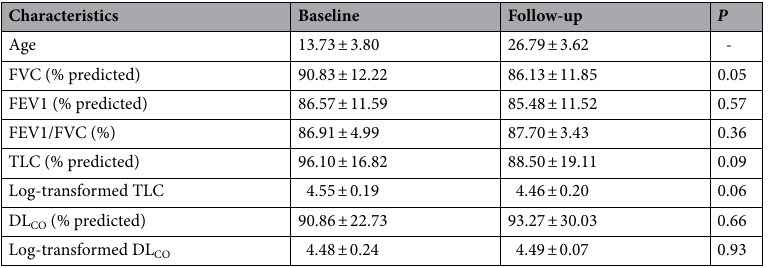
Table 4. Longitudinal changes in lung function over time (N = 23). Values are presented as mean ± standard deviation unless otherwise specified. P values by paired sample t -test. FVC, forced vital capacity; FEV1,